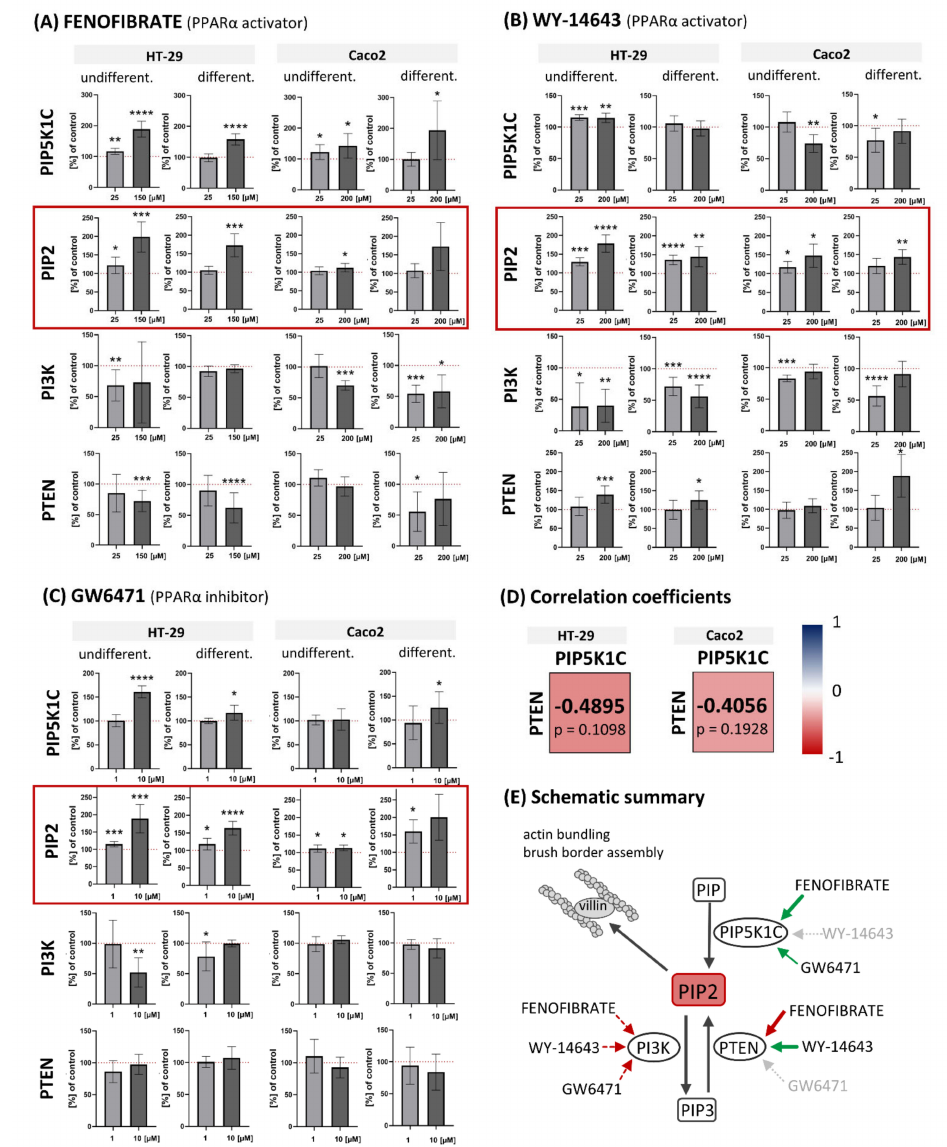
Figure 1. Effect of PPAR α activators fenofibrate ( A ) and WY-14643 ( B ) and PPAR α inhibitor GW6471 ( C ) on expression of PIP5K1C, PIP2, PI3K, and PTEN. Relative expression of proteins of interest in comparison to control was measured by In-Cell ELISA. Results are shown as mean ± SD ( n = 6). Red dotted line represents control cells: DMSO treated undifferentiated or differentiated cells (100%). HT-29 cells were differentiated by sodium butyrate, Caco2 cells were differentiated by post-confluent growth (14 days). Note the increase in PIP2 expression in both used cell lines after PPAR α ligands treatment (red rectangles). Statistically significant results in comparison to control cells are marked by * p ≤ 0.05, ** p ≤ 0.01, *** p ≤ 0.001, **** p ≤ 0.0001. ( D ). Relationship between changes in expression of PIP5K1C and PTEN in HT-29 and Caco2 cell lines are shown as Spearman correlation coefficients. Changes in expression of these proteins after PPAR α ligand treatment showed a moderate negative correlation in both cell lines. ( E ) Schematic summary of obtained results. Detected increase in PIP2 observed after fenofibrate, WY-14643, and GW6471 treatment could explain our previous results reported increase in villin expression under the same experimental conditions [18]. The effect of PPAR α ligands is illustrated by arrows: green—increase in expression, red—decrease in expression, grey dotted—no effect, red dotted—decrease in expression or no effect (the results differ in HT-29 and Caco2 cell